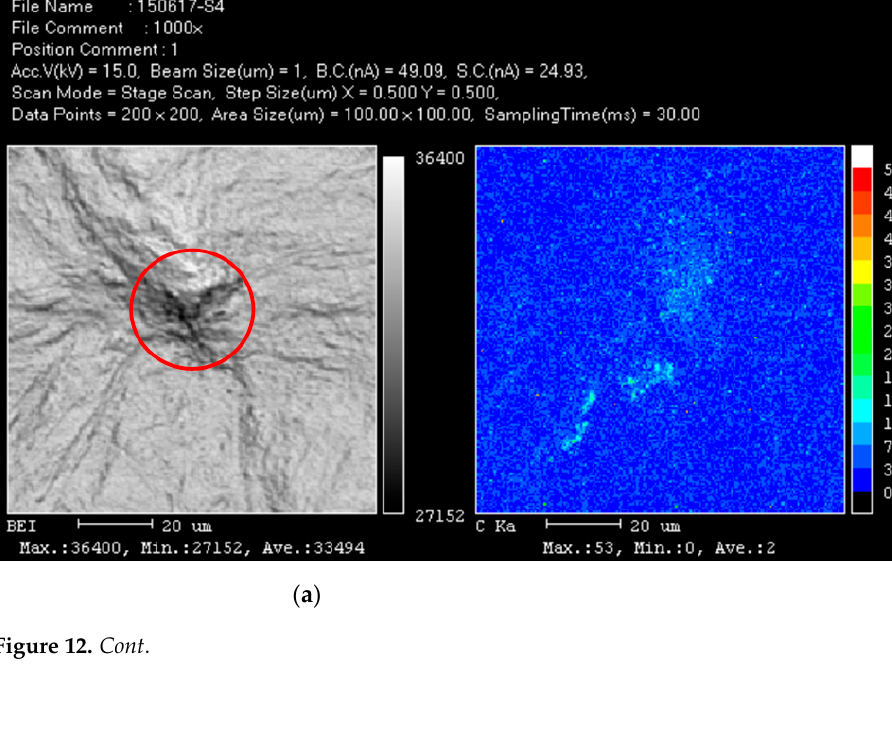
Figure 11. Surface crack initiation of the welded specimen ( σ a = 540 MPa, N f = 1.36 × 10 6 ).